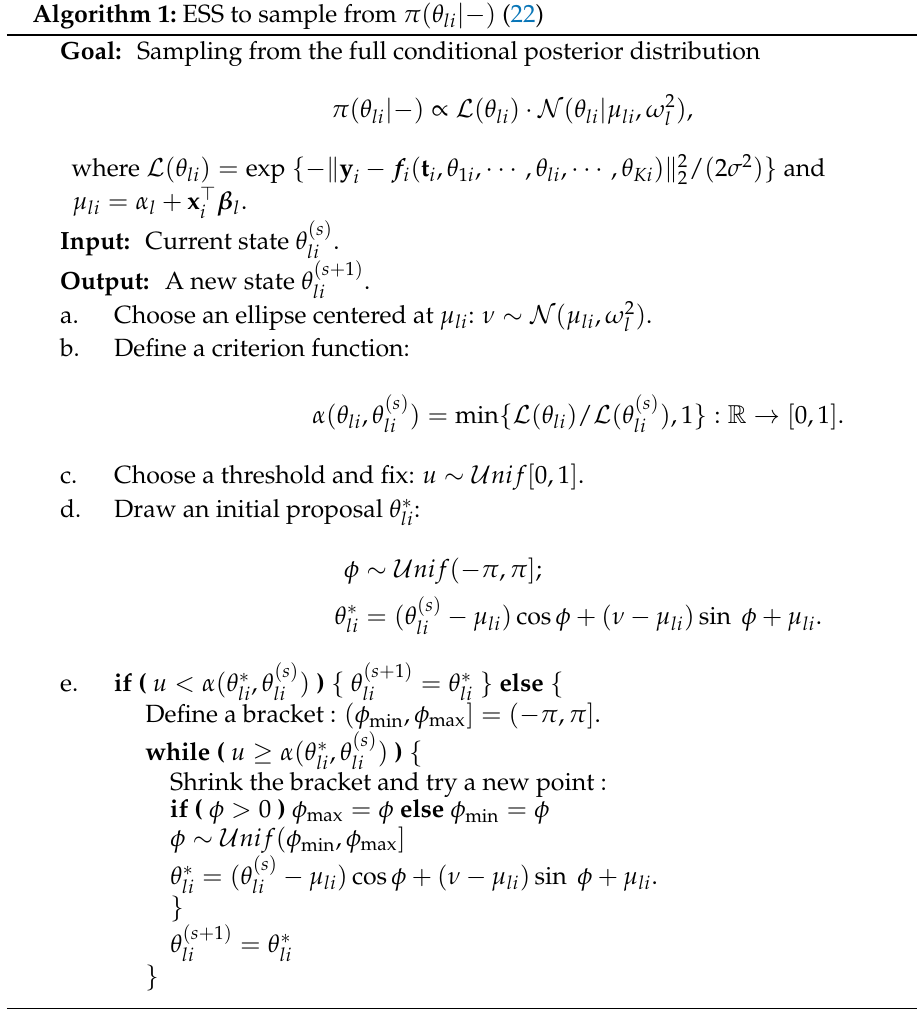
Algorithm 1: ESS to sample from π ( θ li |− )